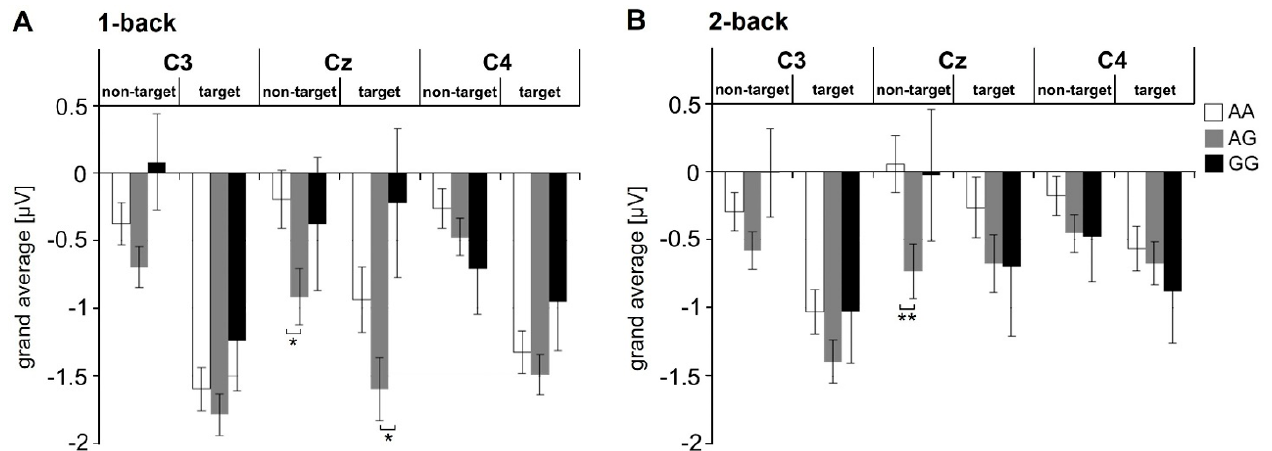
Figure 2. Association of rs2199430 with neural responses to an n-back task. N200 amplitudes associated with CDH13 rs2199430 genotype (AA, AG, GG) in ADHD patients for target and non-target trials of the 1-back ( A ) and 2-back condition ( B ) at central electrode positions (C3, Cz, C4). A significant heterosis effect of rs2199430 occurred in both conditions with mean amplitudes of AG carriers being significantly higher compared to homozygous patients at central electrode position Cz. Asterisks indicate significant differences between genotypes with ** p < 0.01, * p < 0.05. Bars represent means +/ − SEM.